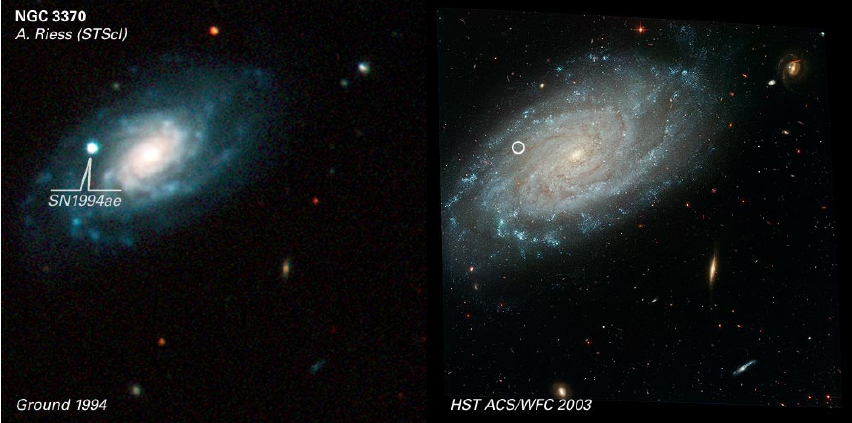
Figure 1. The lower the value of seeing, the clearer the objects from the universe